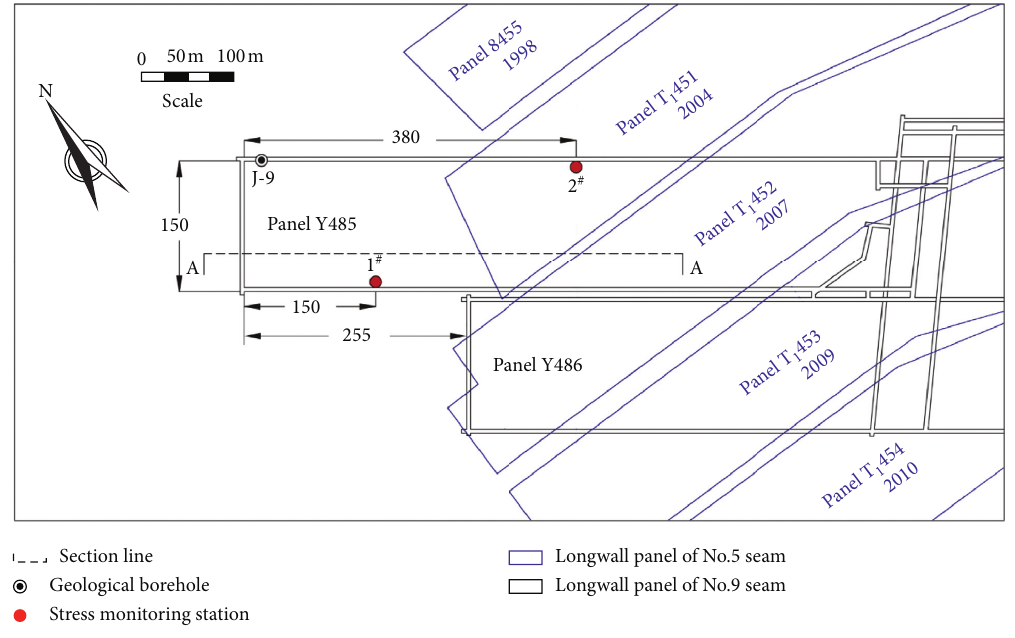
Figure 1: Layout of panel Y485.